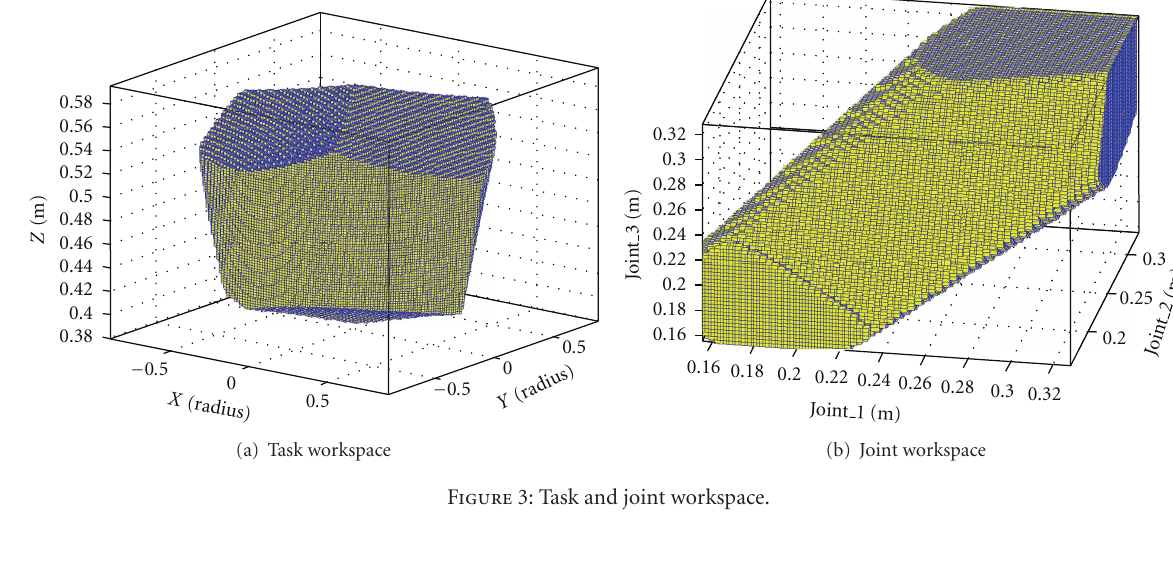
Figure 3: Task and joint